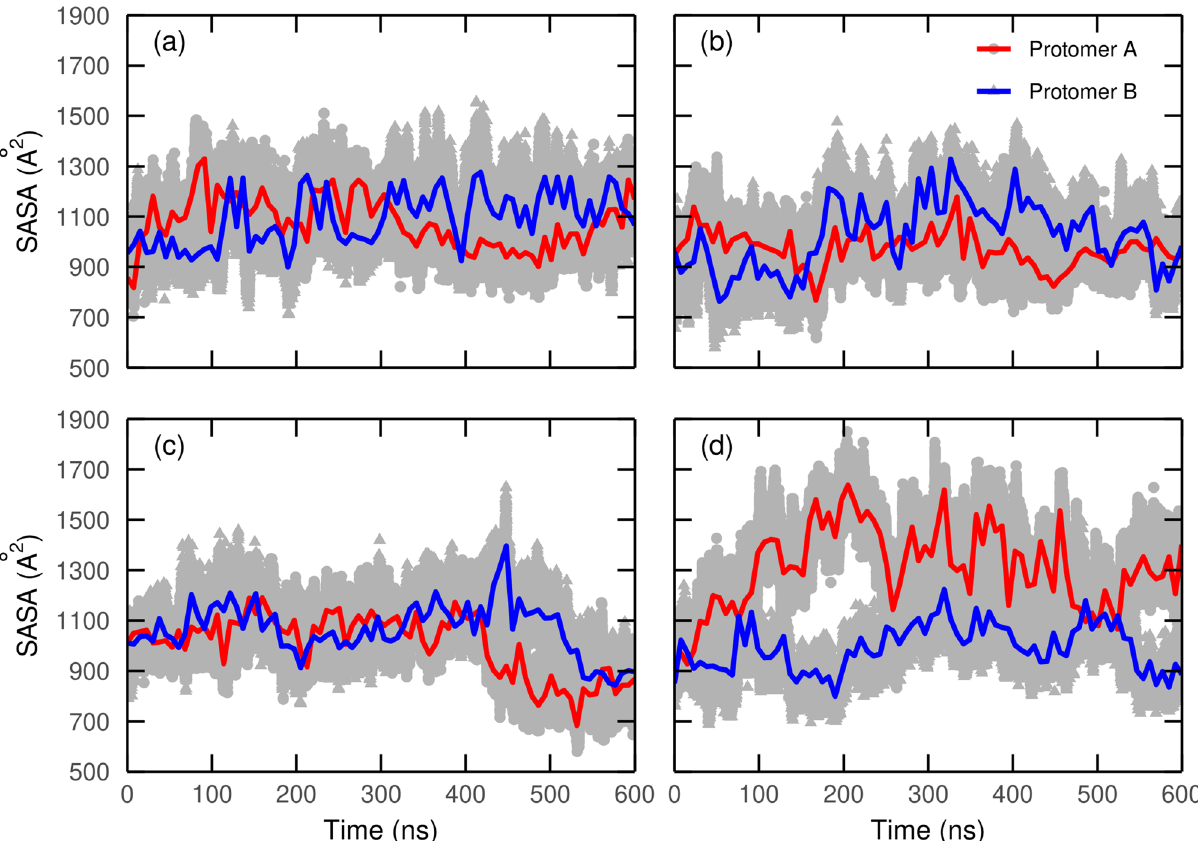
Figure 9. SASA values from SBS in each protomer along simulation time. SASA values correspond to protomer A and protomer B SBSs for ( a ) apo dimeric M PRO or holo dimeric M PRO with ( b ) euchrenone a11, ( c ) dorsilurin E or ( d ) X77 (positive control). Circles represent the real measure of SASA during simulation time for protomer A, while the same is true for triangles and protomer B. Lines are the smoothed values for each protomer (A, red; B, blue) that help in tendency recognition. Smoothing was done through locally estimated scatterplot smoothing (LOESS) using a span of 0.005. As was expected, X77 occupancy substantially increased overall SASA in protomer A SBS, thereby heightening the alternation pattern even without pronounced SBS closing in protomer B. Therefore, it is hypothesized that X77 would be exerting the same effect seen in the natural substrate and thus its main inhibition mechanism would not be the disruption of the